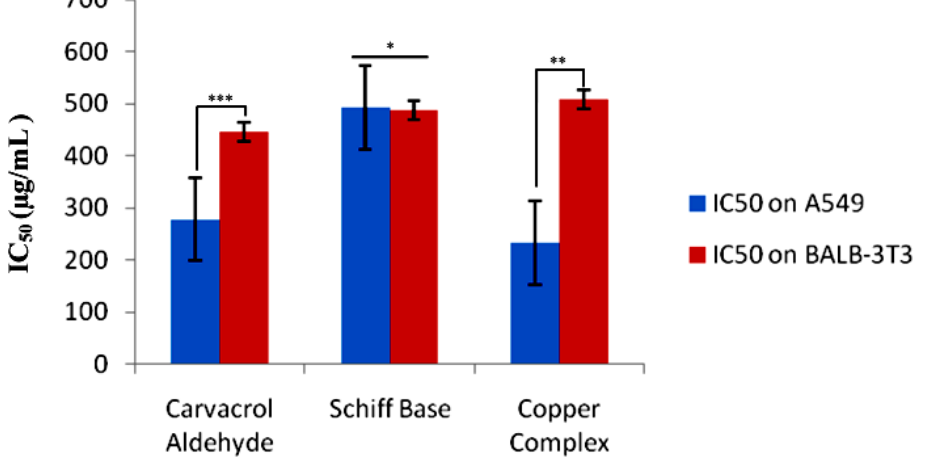
Figure 4. The IC 50 values (mean ± SE) of carvacrol aldehyde, the Schiff base, and the copper– Schiff base complex in A549 and BALB-3T3 cells after 24 h of exposure. Data are expressed as the mean ± SD ( n = 3). * p < 0.05; ** p < 0.01; *** p < 0.001.